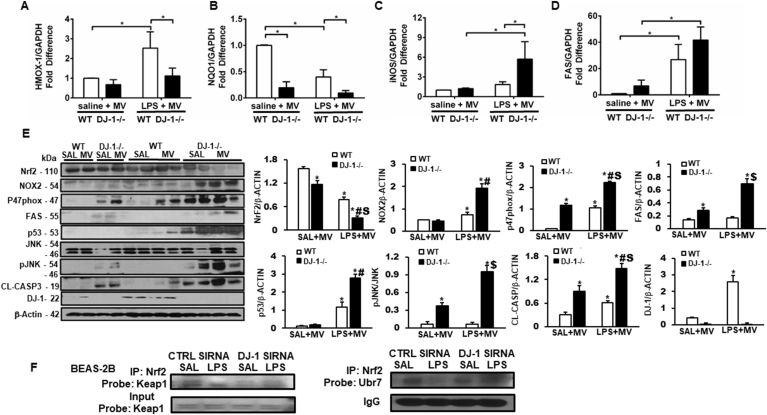
DJ-1 deficient animals had increased expression of oxidative stress and cell death markers in a “two-hit” model. A) mRNA Expression of Heme oxygenase-1(HMOX-1), B) NADPH quinone oxidoreductase 1 (NQO1), C) inducible NOS (iNOS), D) and FAS in WT and DJ-1−/− mechanically ventilated (MV) mice with either saline or LPS administration. Data are presented as means ± SEM (n = 6–8 mice, *p < 0.05, two-way ANOVA). E) Western blots showing protein expression of Nrf2, NADPH oxidase 2 (NOX2), p47phox, FAS, p53, JNK, pJNK, cleaved caspase-3, DJ-1 and B-ACTIN. Densitometry measurements (protein/β-actin) are mean + SEM. n = 2–4. *p < 0.05 vs. WT saline (SAL) + MV, #p < 0.05 vs. WT LPS + MV, $p < 0.05 vs. DJ-1−/− SAL + MV. F) Western blot showing immunoprecipitation with Nrf2 and probing for Keap1 or Ubr7 in Beas-2b cells with control or DJ-1 siRNA (n = 2 independent experiments).